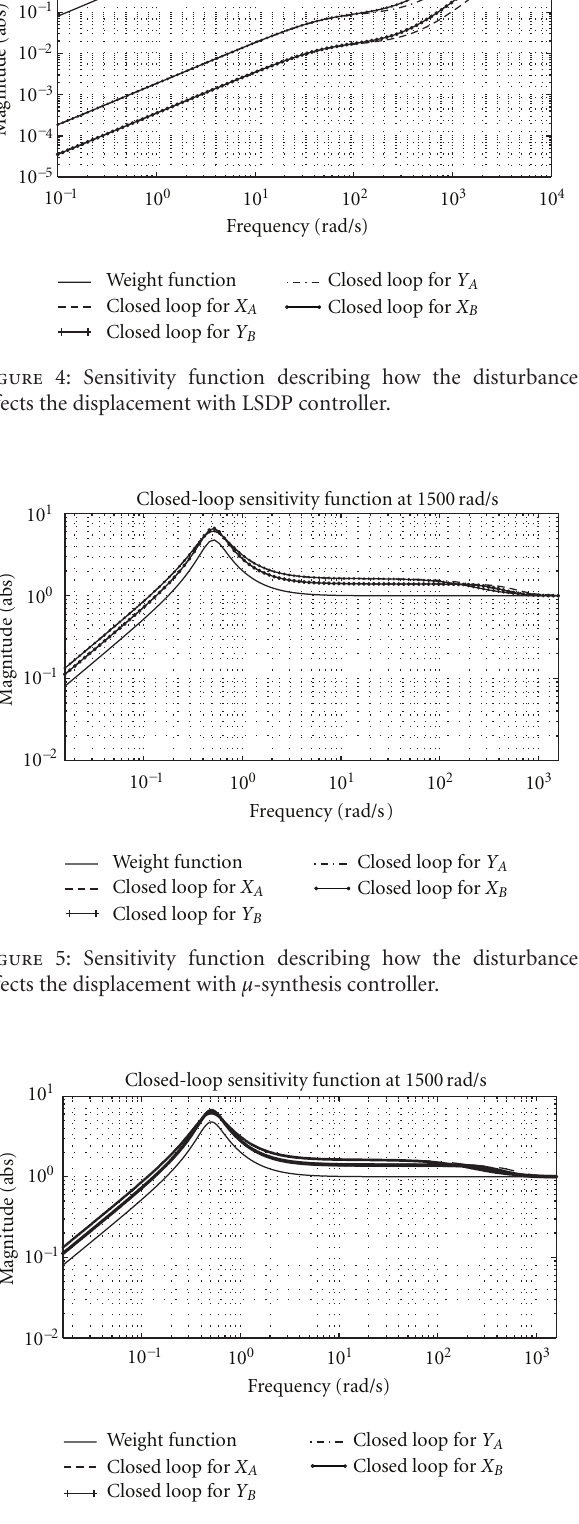
Figure 6: Sensitivity function describing how the disturbance a ff ects the displacement with Sub( H ∞ )